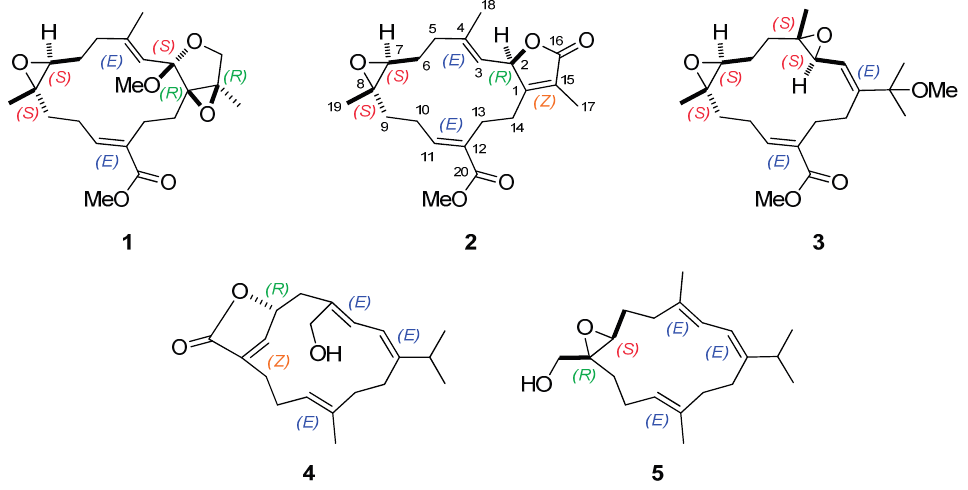
Figure 1. The structures of (+)-1,15-epoxy-2-methoxy-12-methoxycarbonyl-11 E - sarcophytoxide ( 1 ), (+)-2- epi -12-methoxycarbonyl-11 E -sarcophine ( 2 ), 3,4-epoxyehrenberoxide A ( 3 ), ehrenbergol D ( 4 ) and ehrenbergol E ( 5